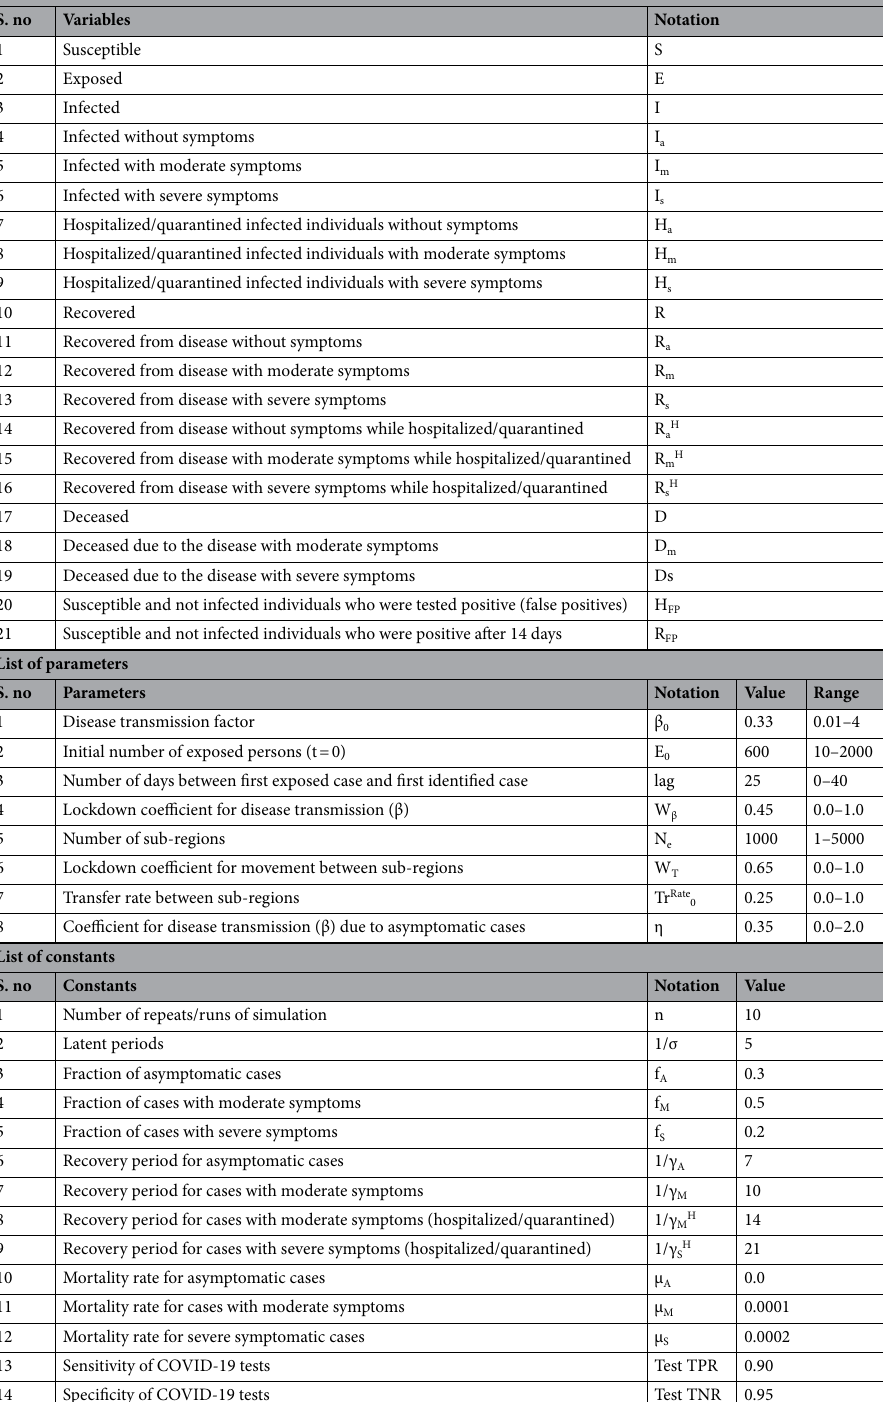
Table 1. List of variables, constants and parameters used in the